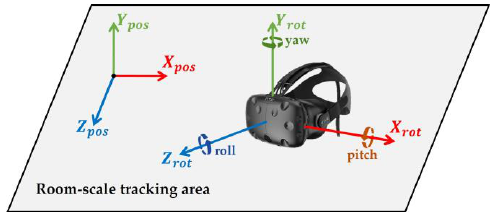
Figure 1. Room-scale position and orientation tracking system.